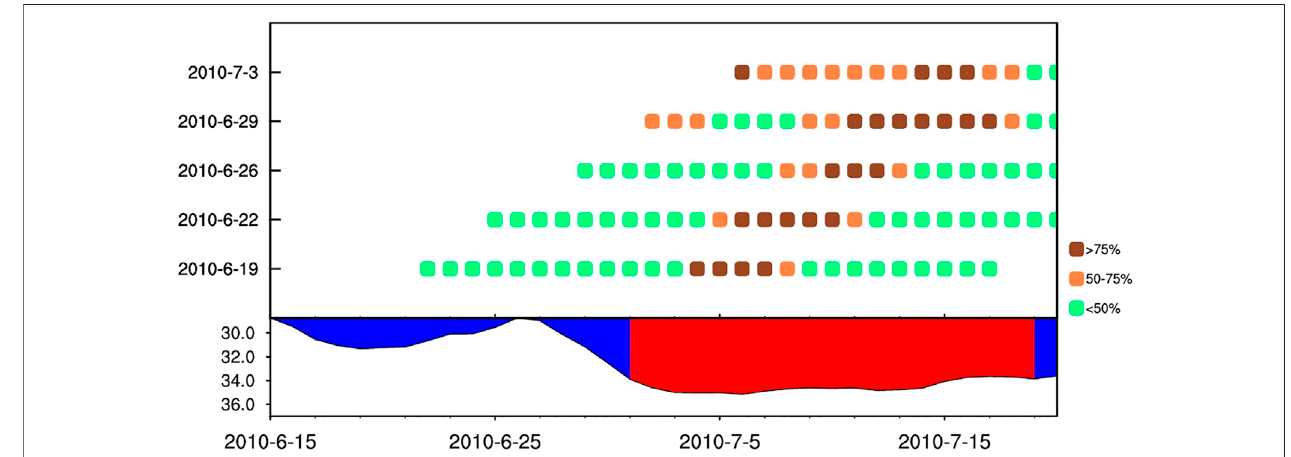
FIGURE 12| Observed HWI (lower part) and probabilistic forecasting HWI (upper part) by BMA initiated from 2010.6.19 to 2010.7.3 at grid 24 ° N, 113 ° E. Red fi lled area in the lower part is the observed heatwave from 2010.7.1 to 2010.7.19. The probabilistic levels are represented by different colors in the small square.